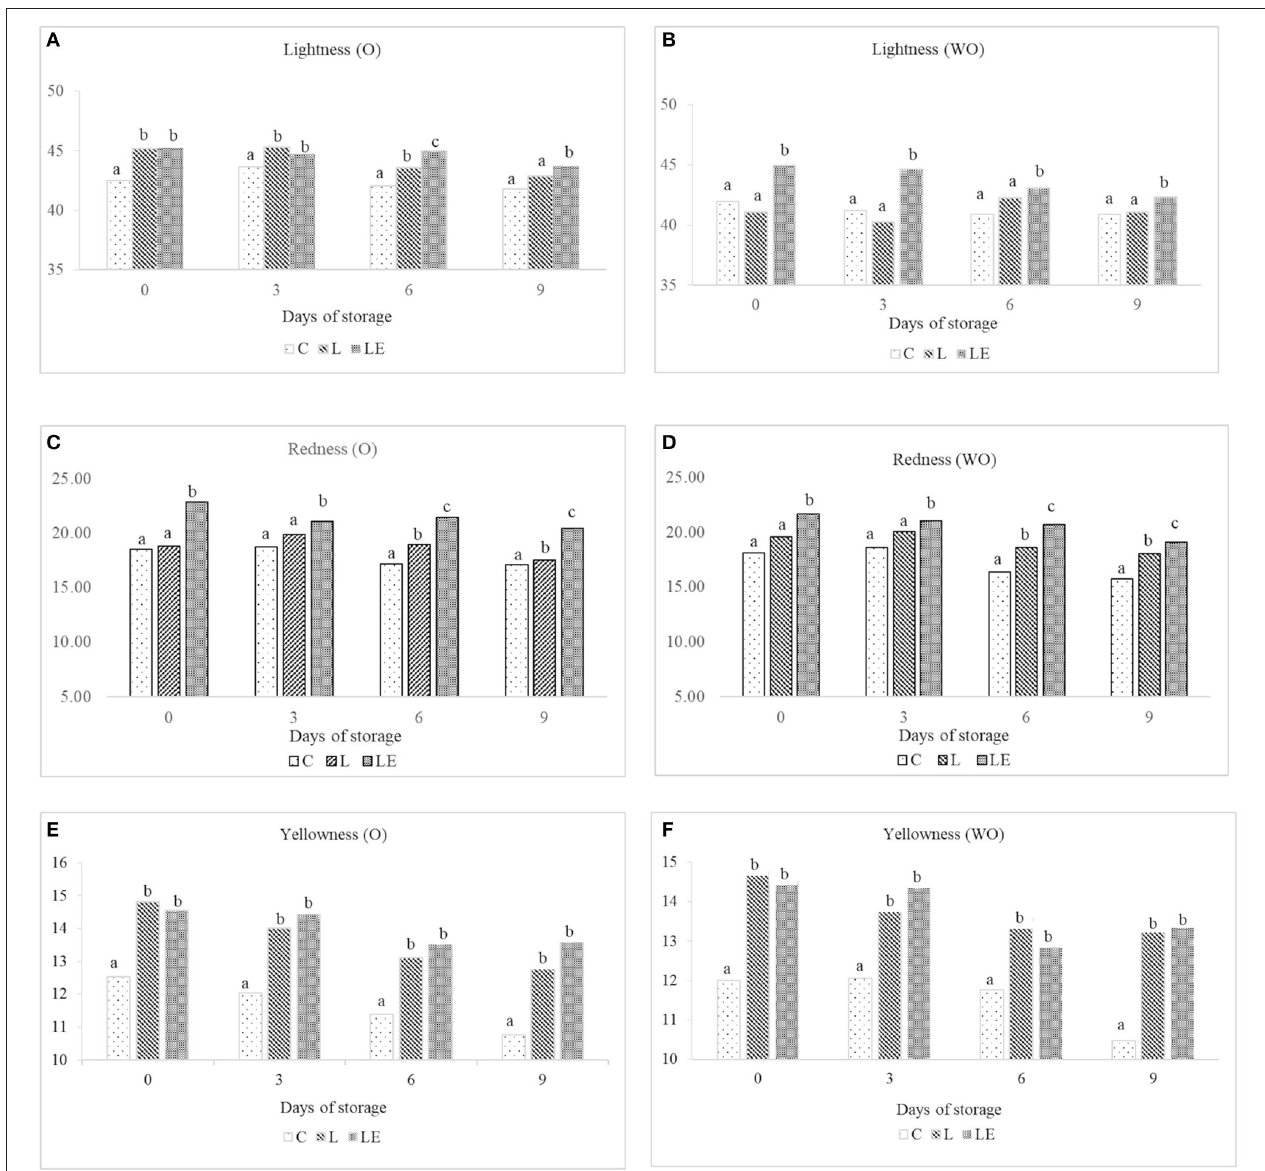
FIGURE 2 | Effect of the experimental diets (C, L, and LE) on Lightness, L* (A,B) redness, a* (C,D) , and yellowness, b* (E,F) of Marchigiana beef meat treated with (O) and without essential oils (WO) during the storage time. C, Control; L, Linseed; LE, Linseed and vitamin E. Different letters on the top of the bars denote significant differences ( P < 0.05) between groups during days of